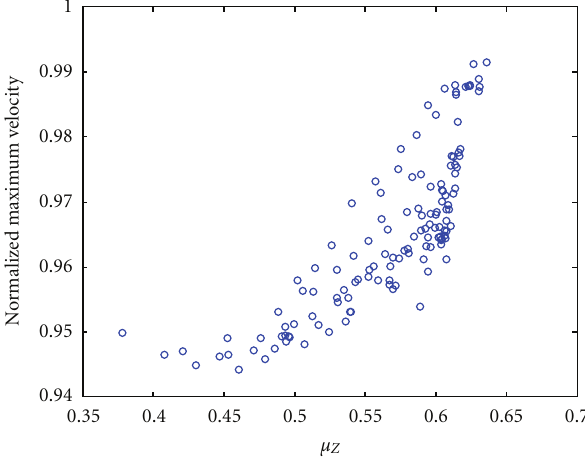
Figure 25: Scatter diagram of DSI μ Z versus velocity along the Z direction(vertical half-plane YZ with X =